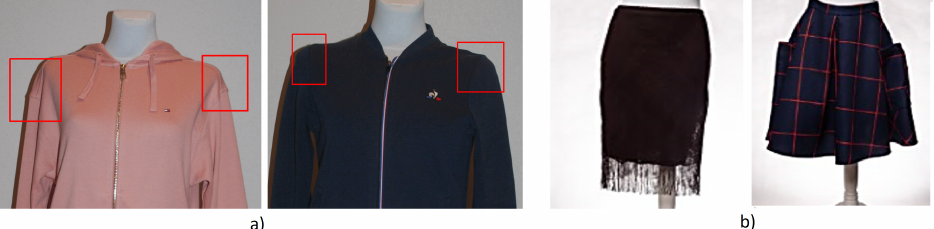
Figure 7. Examples of specific cases: ( a ) in the blazers dataset regarding to shoulders line and ( b ) in skirts dataset regarding to the bottom line.